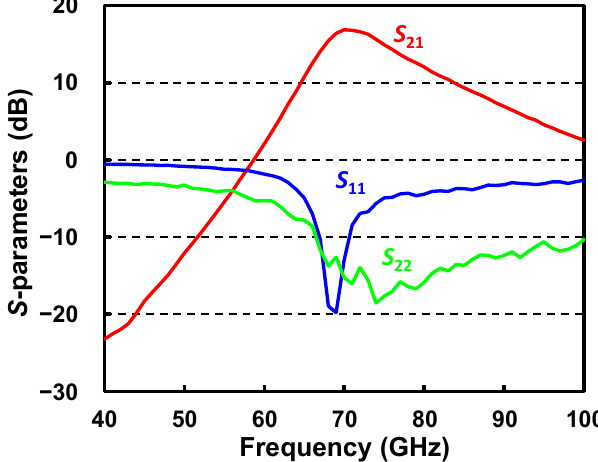
Figure 7. Measured S -parameters versus frequency.